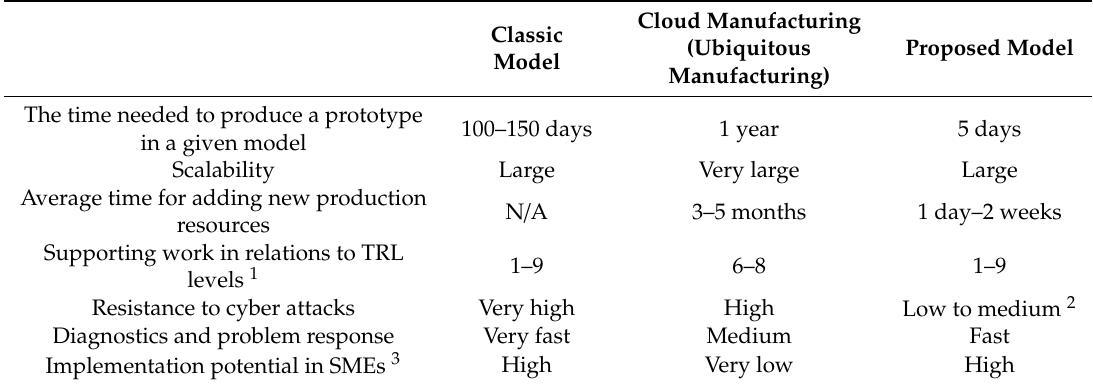
Table 1. Comparison of model-specific features with regard to RDRP with “last resort” ventilator development as an